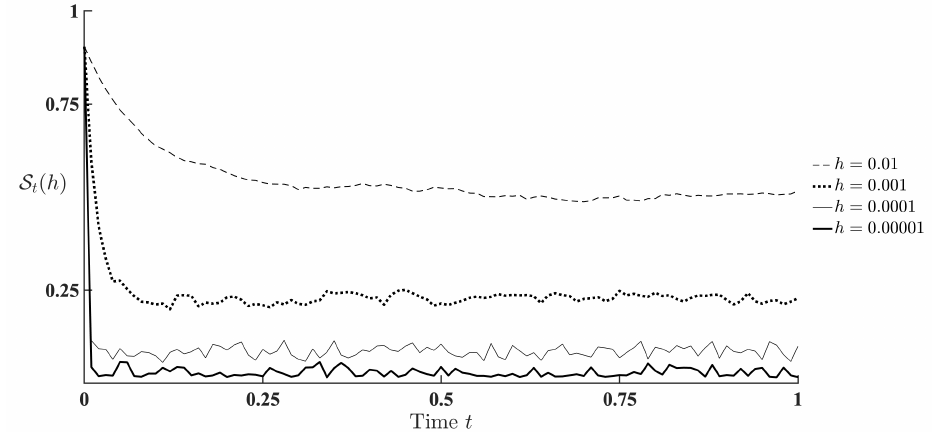
Figure 1. Estimation quality index S t ( h ) depending on the time-discretization step h